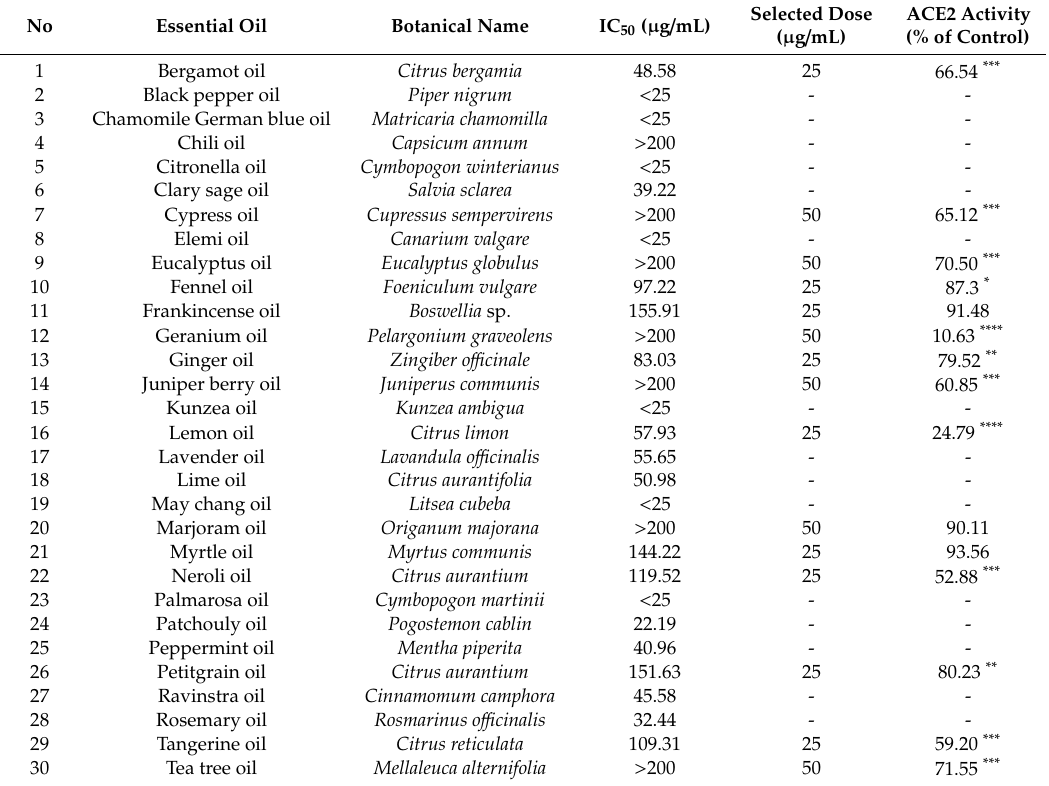
Table 1. Cytotoxic and ACE2 inhibitory e ff ects of essential